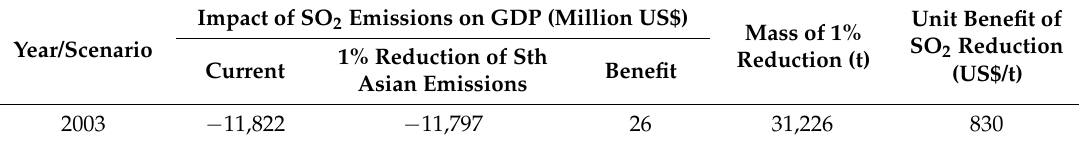
Table A4. Impact on South Asian GDP of current levels of atmospheric SO 2 and the mass and corresponding benefit of a 1% reduction in SO 2 emissions, both absolute and per tonne of SO 2